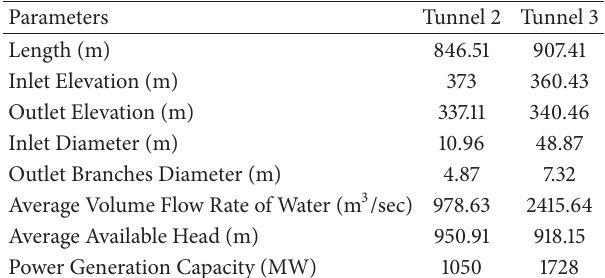
Table 1: Tunnels parameters.